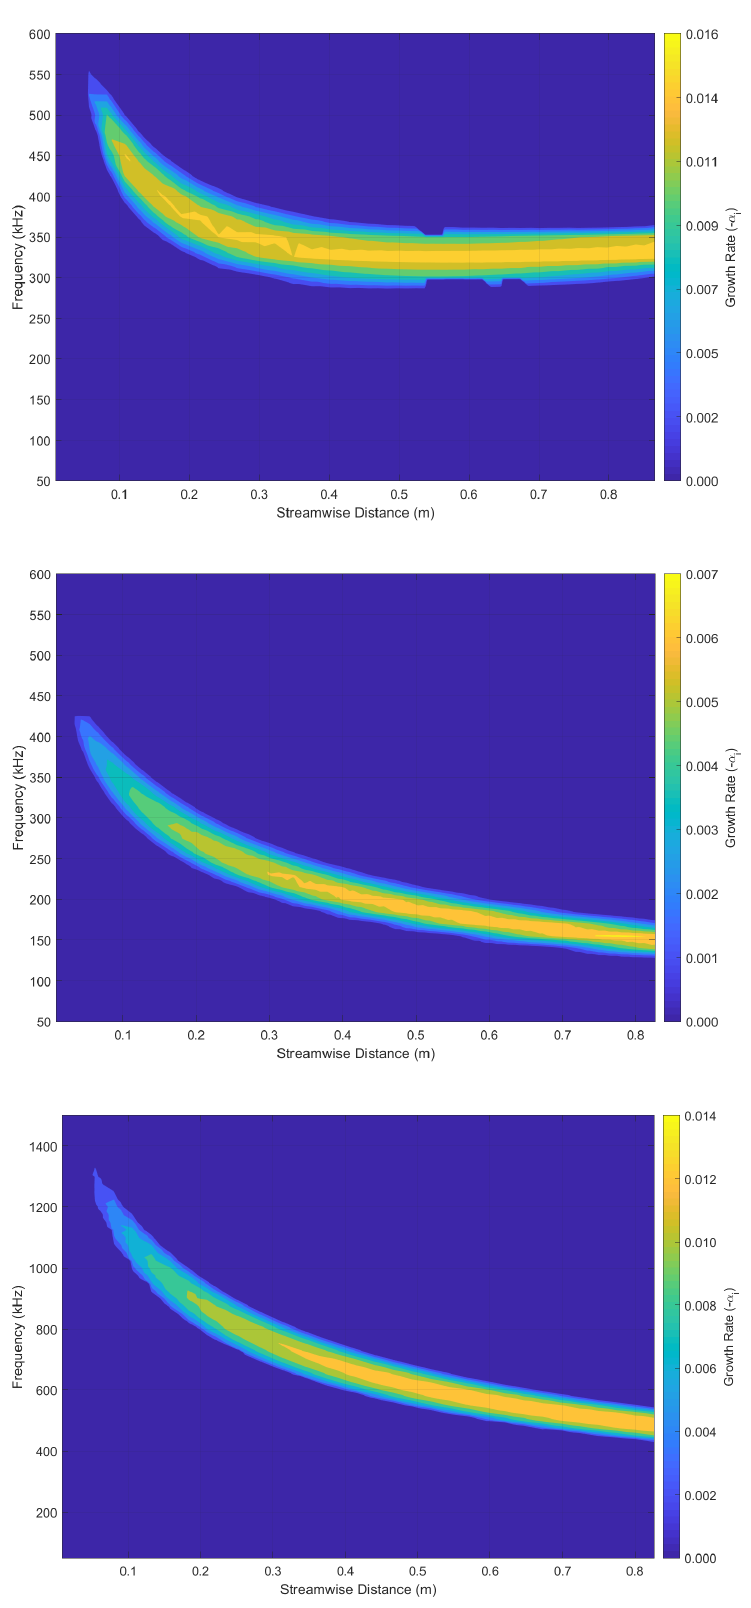
Figure 2. LST results— Upper : Notre Dame tunnel conditions 4 m flared cone. Middle : Notre Dame tunnel conditions straight cone. Lower : HIFiRE flight conditions straight